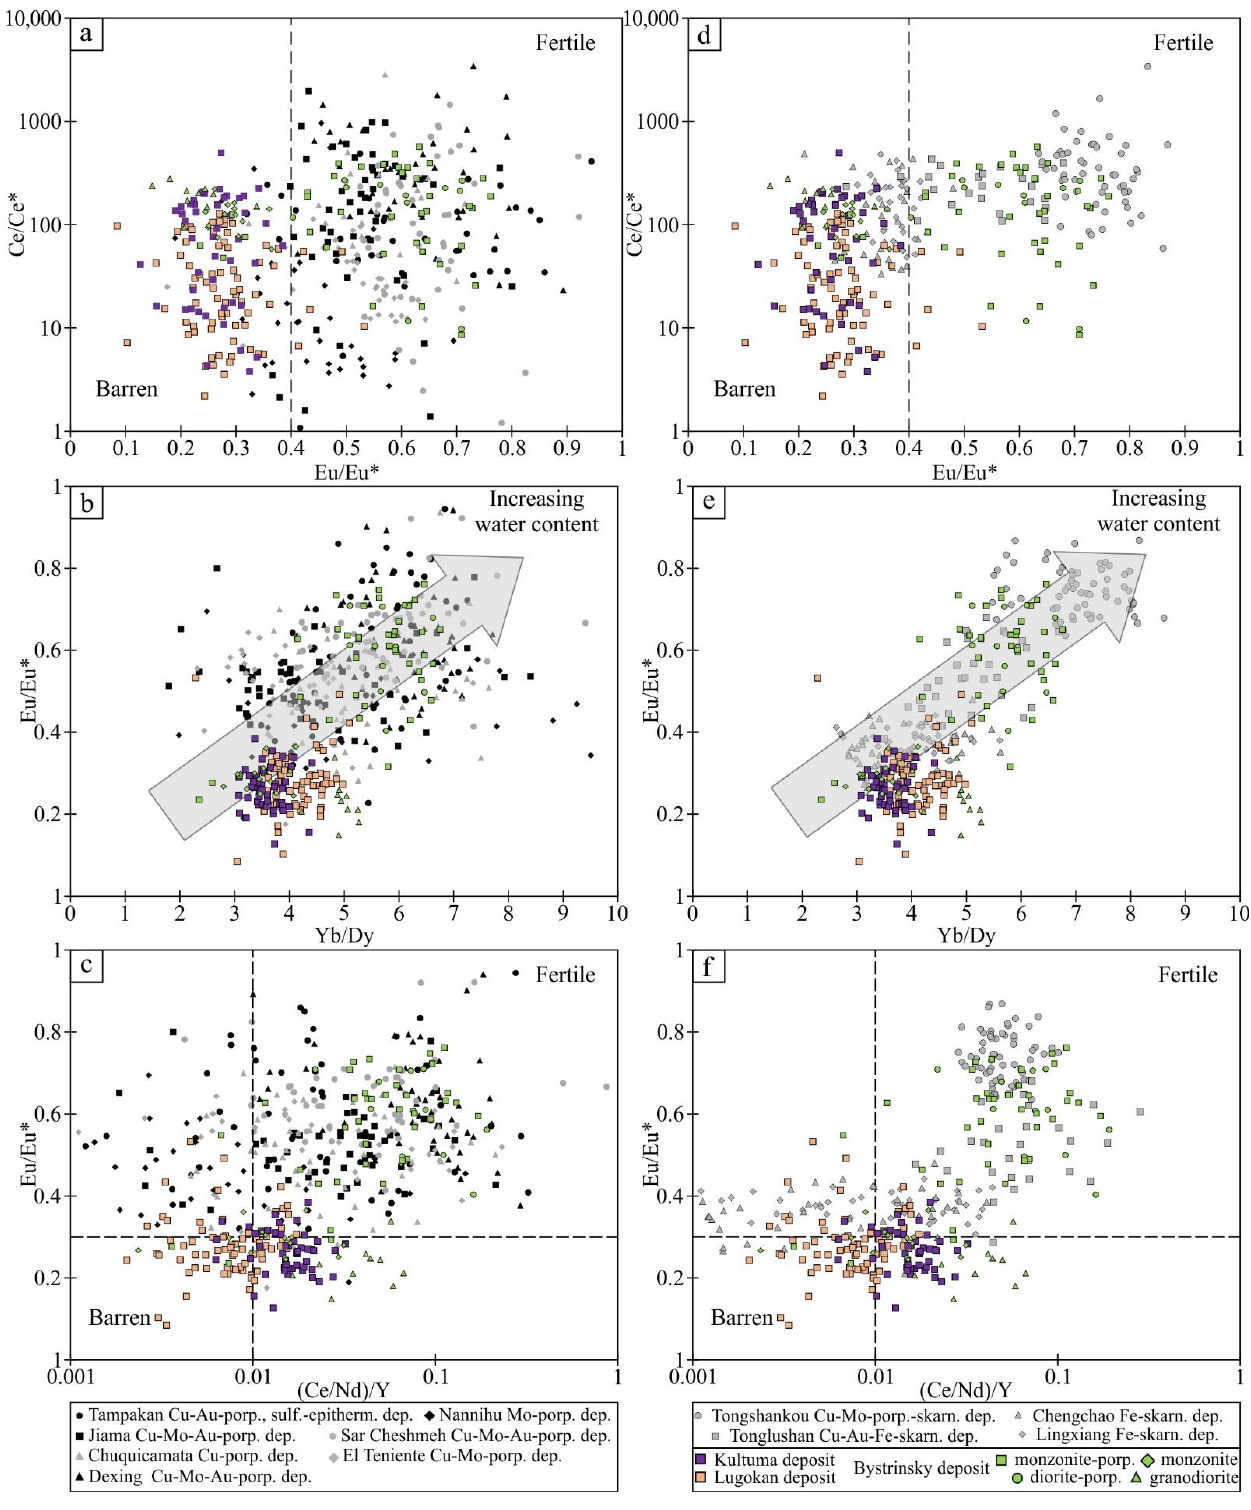
Figure 11. Plot of zircon ( a , d ) — Ce/Ce* versus Eu/Eu*; ( b , e ) — Eu/Eu* versus Yb/Dy; ( c , f ) — Eu/Eu* versus (Ce/Nd)/Y.